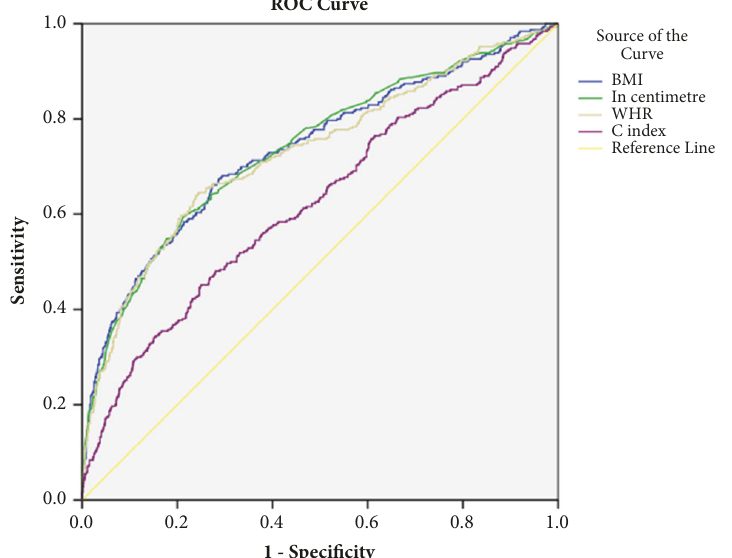
Figure 2: ROC curves that compare four anthropometric indicators of obesity as discriminators of hypertension (girls). BMI: body mass index, in centimeter-waist circumference; WHR: waist-height ratio; C index: conicity index.